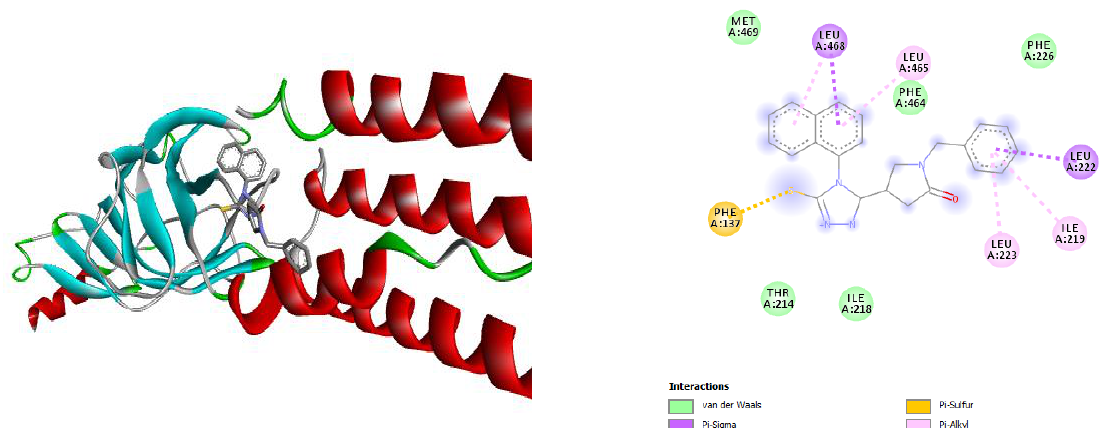
Fig 7. Superposition of molecule 11 and diagram of intermolecular interactions in complex with nicotinic acetylcholine receptor (PDB ID: